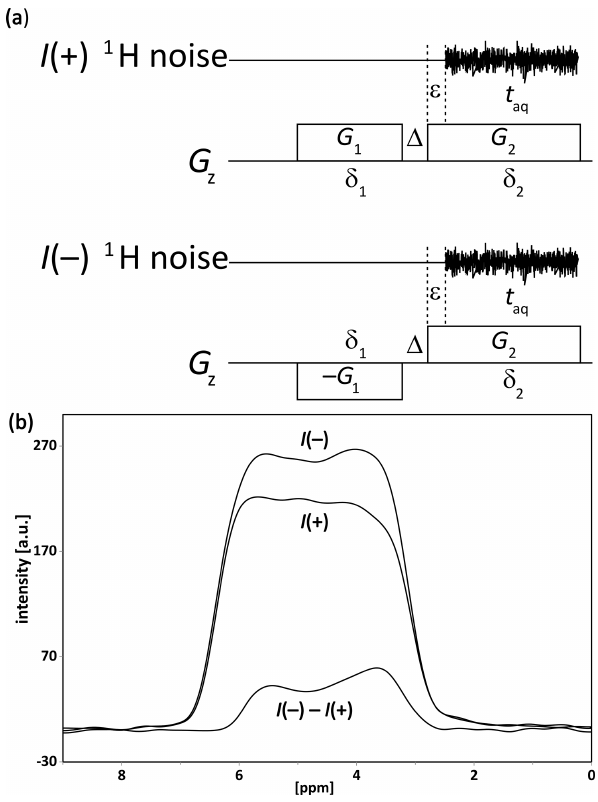
Figure 1. (a) The two-gradient pulse sequence (notably devoid of any RF pulses) used to demonstrate the principle of the spin distributions obtained from an inverse Laplace trans- noise gradient echo (SNGE). The noise blocks of the I ( + ) and Figure 2. T ∗ 2 form (ILT; as implemented in MATLAB; MATLAB, 2010) of the I ( − ) experiments are stored separately and processed as described data sets measured in the I ( + ) and I ( − ) 1 H SNGE experiments for elsewhere (Nausner et al., 2009; Pöschko et al., 2017). The power different delays (cid:49) . The results in panel (a) are obtained from the spectra of I ( + ) and I ( − ) shown in panel (b) were used to calcu- 1 H signal of H late a difference spectrum I ( − ) − I ( + ). The experimental parame- 2 O in 90%:10% H 2 O:D 2 O (relaxation constant is about 160ms) and in panel (b) from the 1 H signal of 90% ace- , δ 1 = 2, (cid:49) = 0 . 1ms, a gradient stabi- ters were G 1 = G 2 = 3 . 2 mT m tone with 10% acetone-d6 (relaxation constant is about 62ms). (cid:49) lization delay (cid:15) = 0 . 07ms, and an acquisition time t aq = 3 . 69ms. varied from 0 to 70ms at constant parameters of G 1 = 1 . 26, G 2 = In total, 2048 noise blocks were Fourier transformed, and their , δ 1 = 35ms, a gradient stabilization delay (cid:15) = 0 . 07ms, 10 . 7 mT power spectra were added for each profile. The line shapes in panel m and an acquisition time t aq = 3 . 69ms. Thus, with the ILT analy- (b) should ideally be rectangular gradient profiles. Deviations are sis, it is possible to extract a distribution of relaxation components caused by the non-ideality of the gradient system, the finite sample f ( T 2 ) (Berman et al., 2013; Rodin, 2018). In particular, for pure limits, and residual radiation damping. liquids, this distribution f ( T 2 ) showed one relaxation